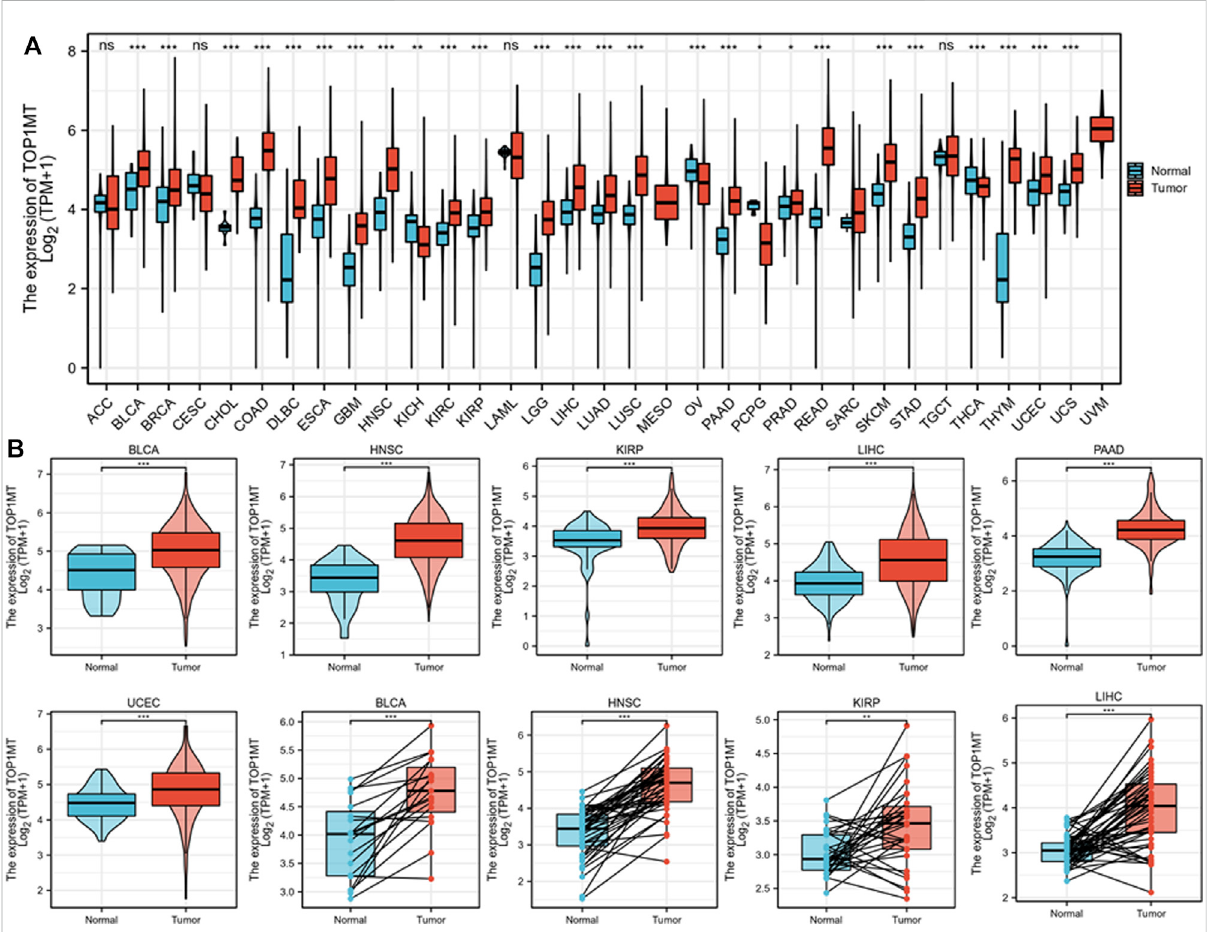
FIGURE 1 Expression pattern of TOP1MT inhuman generalized carcinoma. (A) Assessing mRNA expression of TOP1MT between tumor and normal tissue usingdatadownloaded fromTCGAandGTEx; (B) TOP1MT mRNAexpressioninpatientswithBLCA,HNSC,KIPP,PAAD, UCEC,andLIHCfromTCGA. Log 2 (TPM+1) is used for the logarithmic scale. p p < 0.05, pp p < 0.01 and pp p <